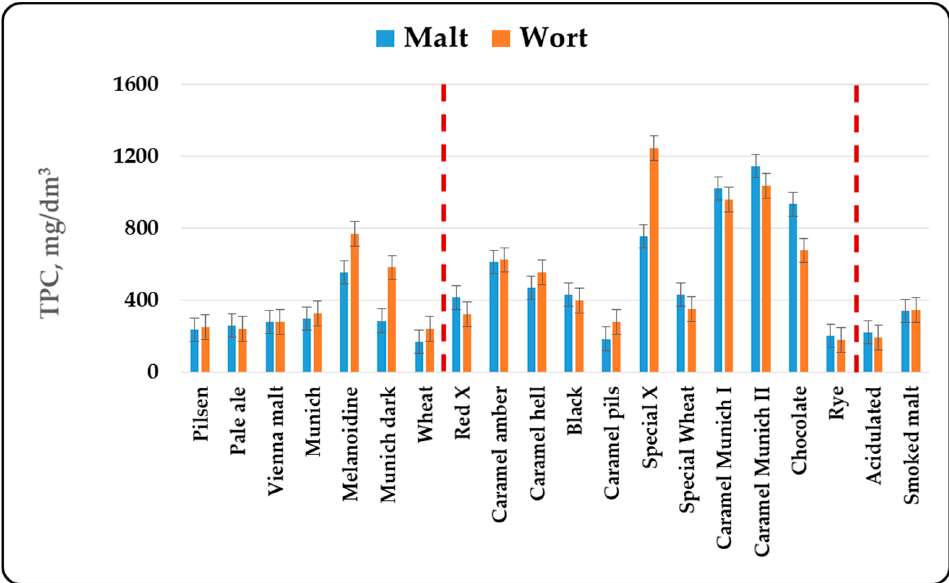
Figure 1. Content of total phenolic compounds in different malt types determined with the Folin- Ciocalteu reagent.